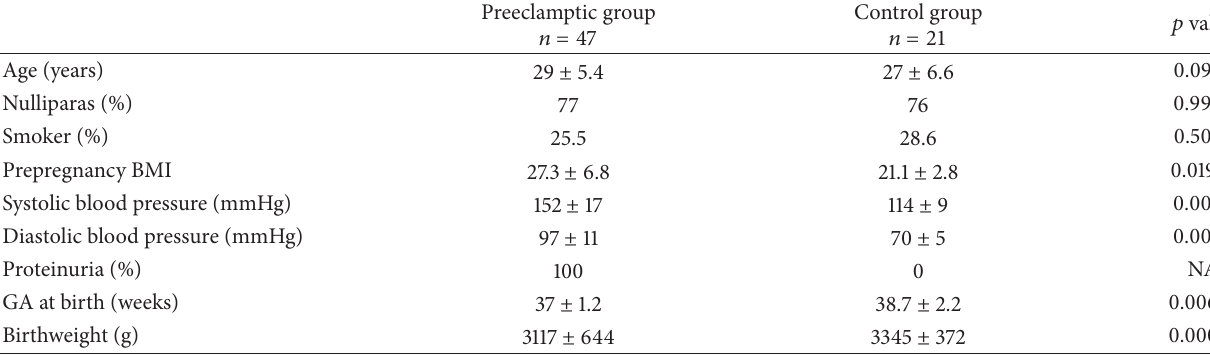
Table 1: Clinical characteristics of the two groups of women: preeclamptic and